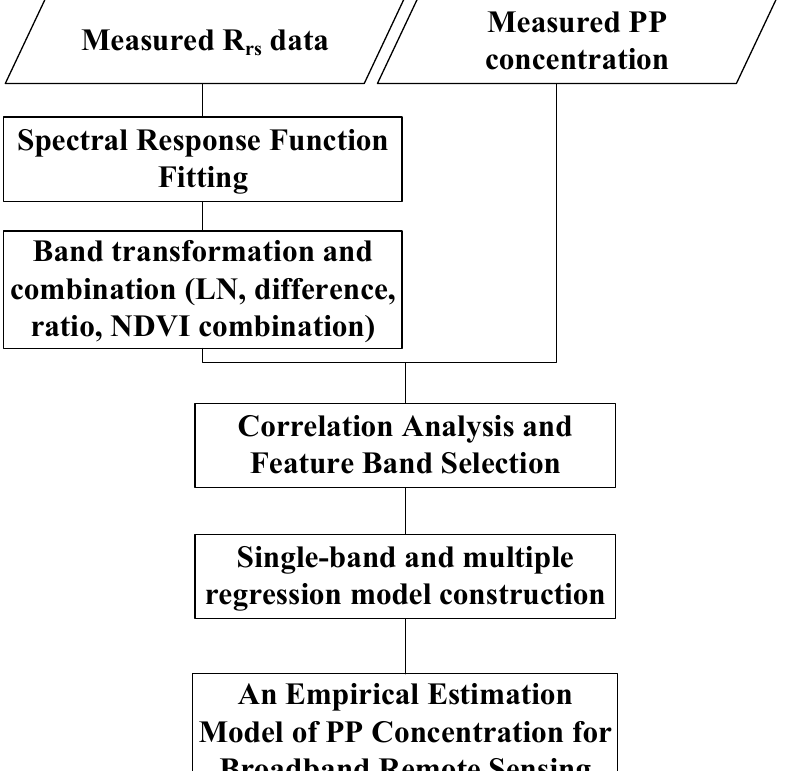
Figure 6. Flow chart of the construction process of an empirical PP concentration estimation model for broadband remotely sensed data.